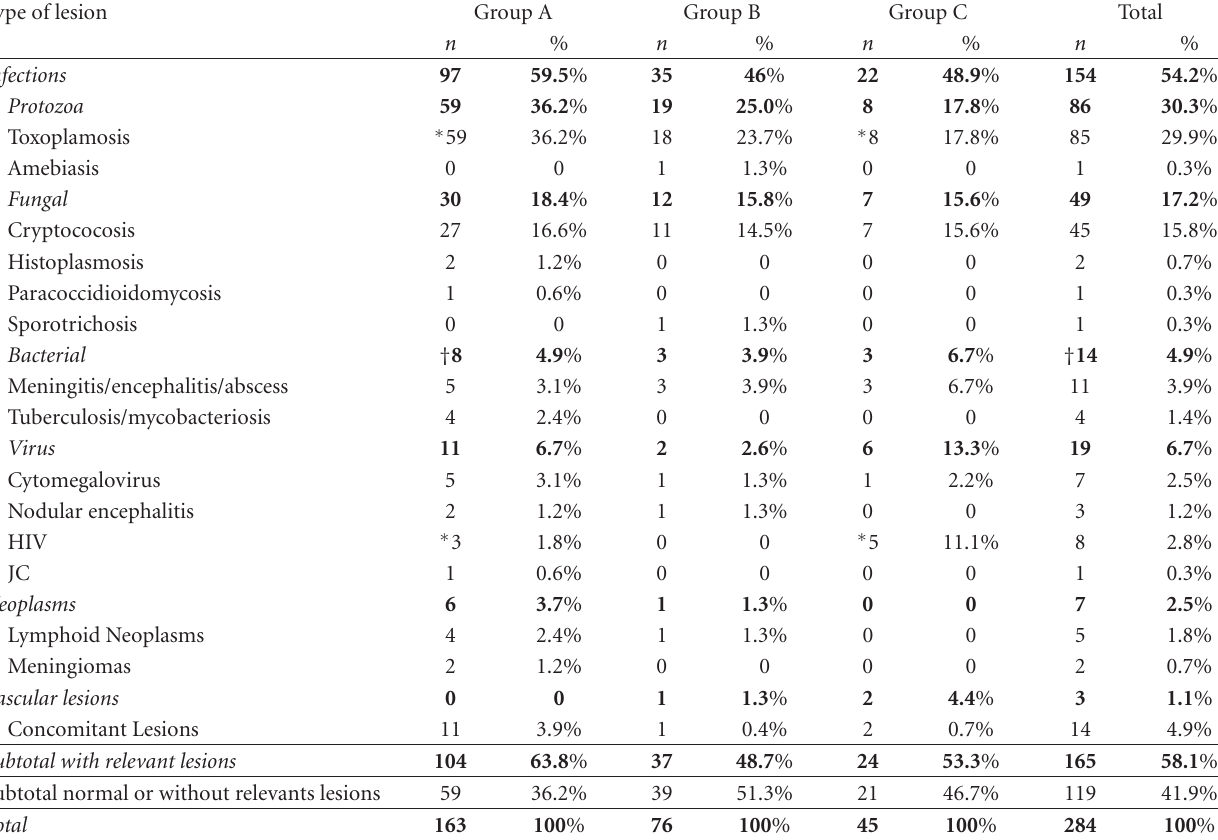
Table 1: Relevant morphological lesions in the central nervous system in 284 autopsies of patients with acquired immunodeficiency syndrome, according to the study